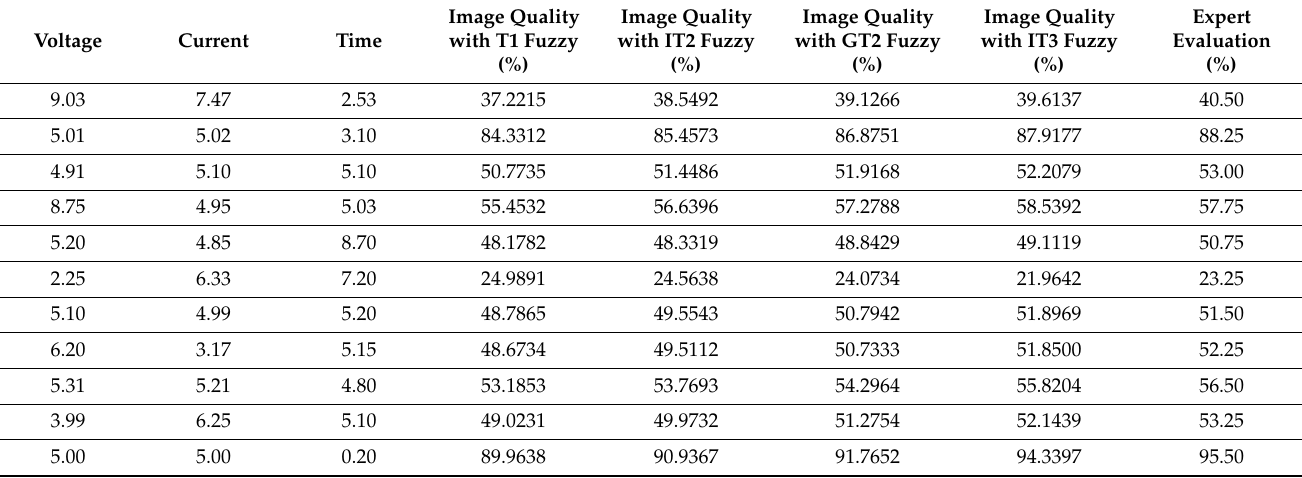
Table 3. Simulation results for a sample of